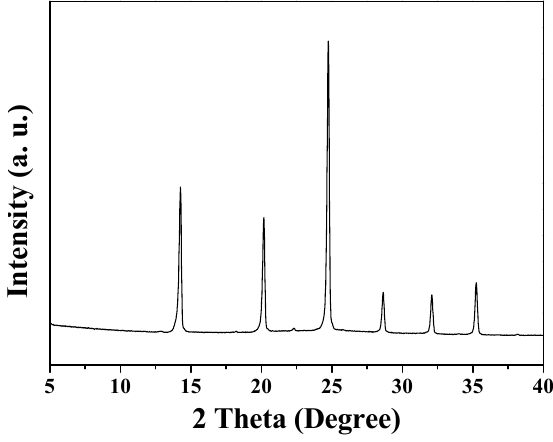
Figure 1. XRD pattern of the as-made S–Si–SOD zeolite synthesized at 200 °C.